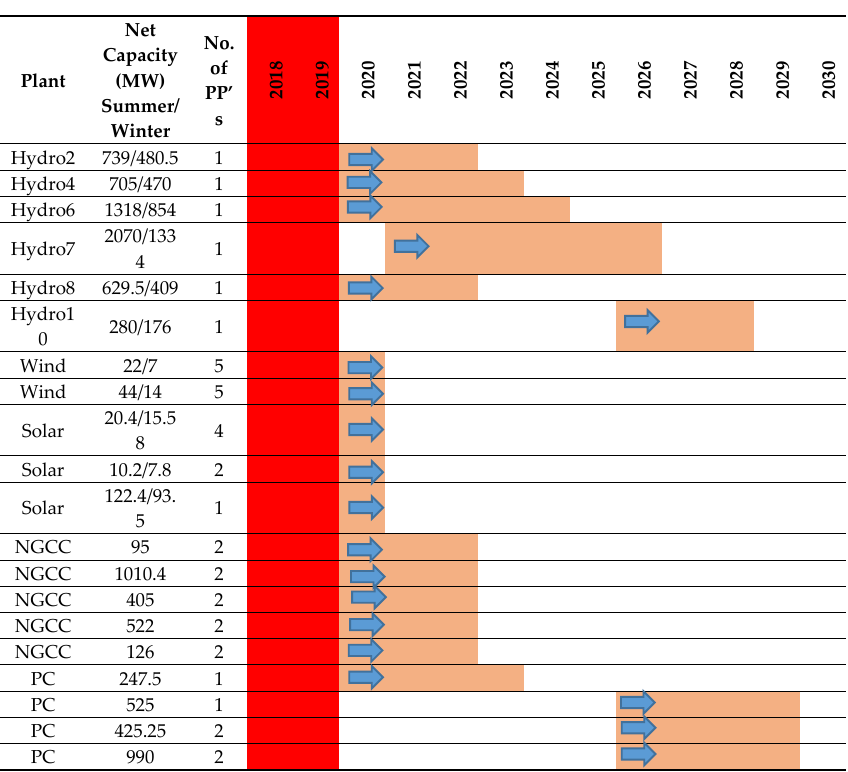
Table A11. Details of the Plants Installation under Capacity Expansion: Normal GDP CCS on New PP’s.